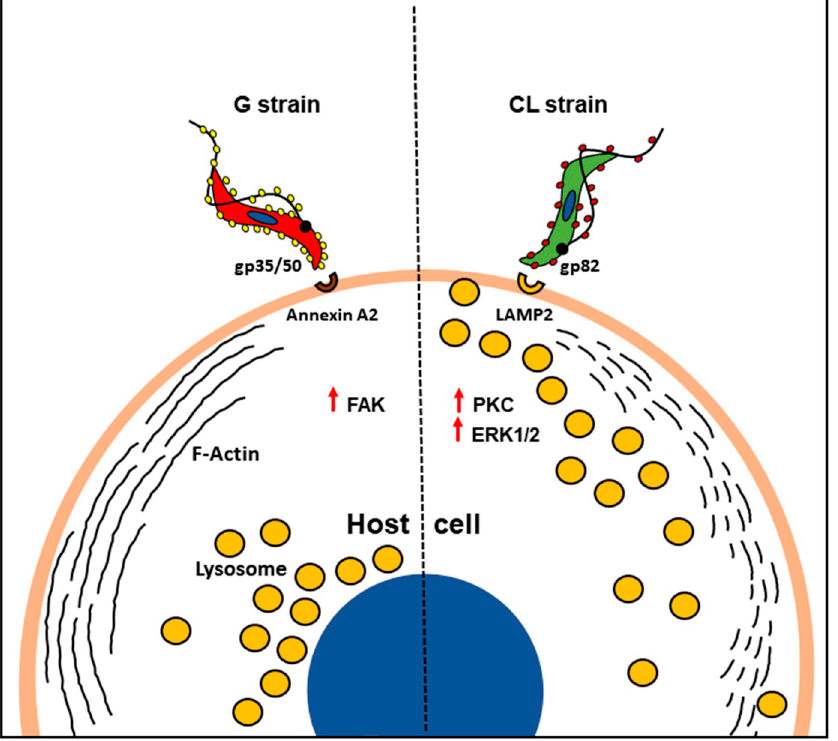
Fig 10. Schematic representation of possible mechanisms of host cell invasion by T . cruzi strains G and CL. Host cell invasion by G strain MT involves the interaction of gp35/50 mucins with annexin A2, FAK activation and F-actin recruitment, whereas CL strain MT internalization relies on the recognition of gp82 by LAMP2, activation of PKC and ERK1/2, disruption of F-actin and spreading of lysosomes to the cell periphery.